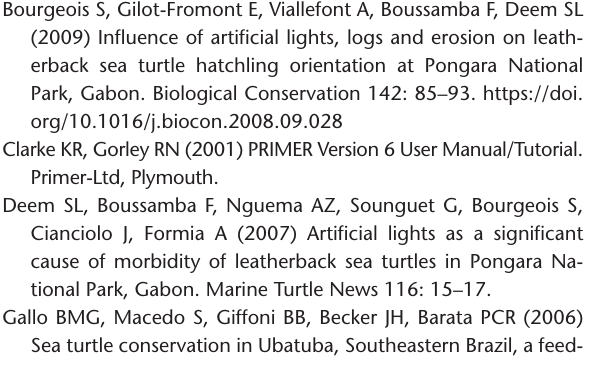
Lepidochelys olivacea (Eschscholtz, 1829) (Mrosovsky and Carr 1967) and Dermochelys coriacea (Vandelli, 1761) (Bourgeois et al. 2009). In all of those studies, severe hatchling disorientation and increased disruption in their ability to find the sea were recorded. The disruption caused by artificial lights on neonate behavior includes crawling in the opposite direction of the ocean (Witherington and Martin 2003), or walking in circular paths, or abrupt changes in direction (Witherington and Bjorndal1991a, Salmon and Witherington 1995, Witherington and Martin